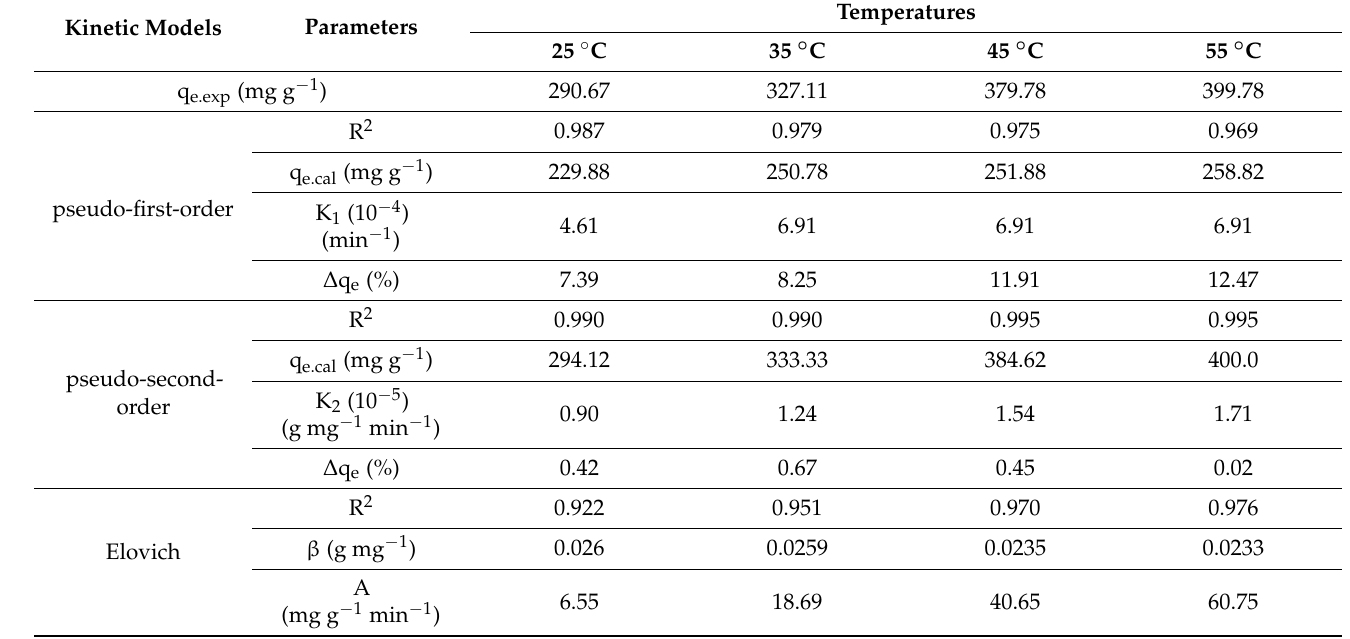
Table 2. Kinetic model constants and correlation coefficients for the adsorption of CR dye onto UCs at different